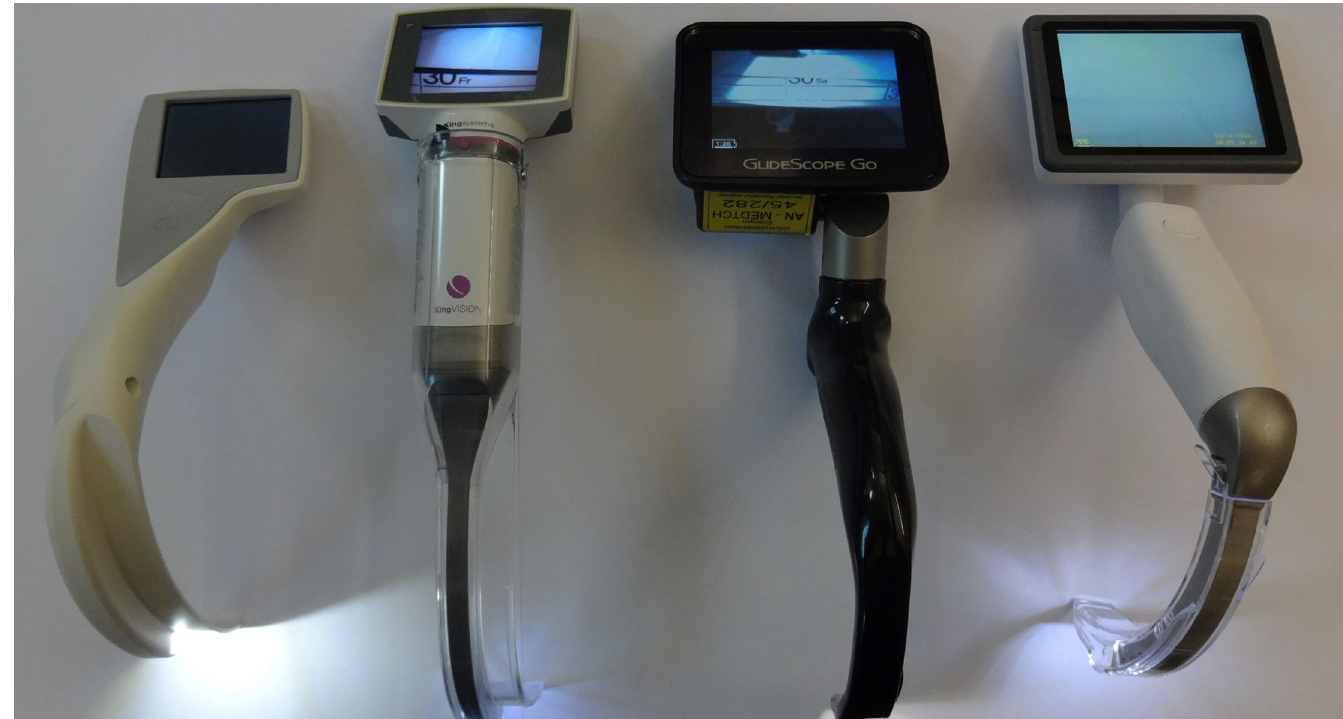
Fig 1. The four different video laryngoscopes (VLs) used in this study. From left to right: I-View ™ one-size single-use VL (Intersurgical Ltd., Wokingham, Berkshire, UK); King Vision ™ aBlade ™ VL with a non-channeled aBlade single-use blade size 3 (Ambu A/S, Ballerup, Denmark); Glidescope 1 Go ™ VL with a LoPro S3 single-use blade (Verathon Inc., Bothell, WA, USA); Dahlhausen VL for single-use blades (Dahlhausen VL) with a MAC DX3 single-use blade (P. J. Dahlhasuen & Co. GmbH, Ko¨ln, Germany).